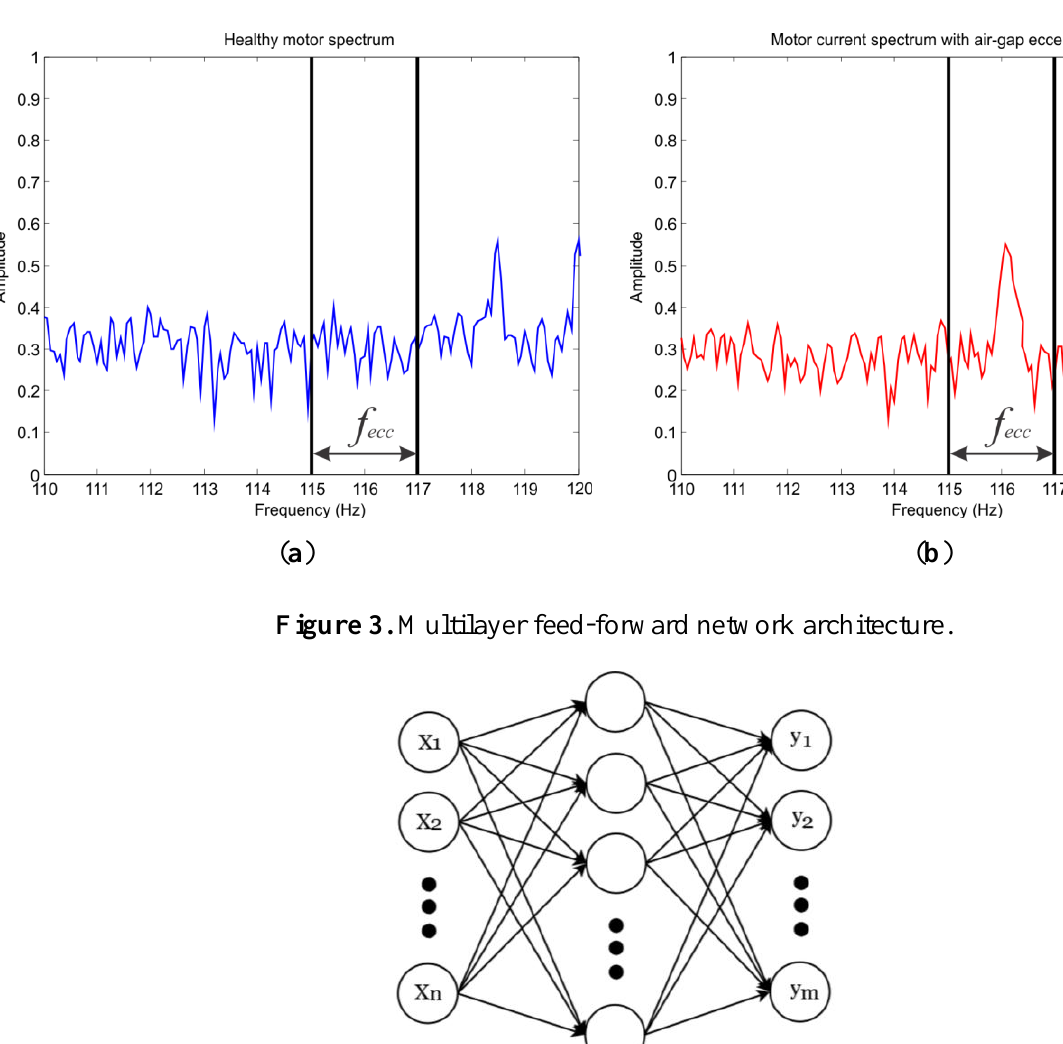
Figure 2. Air-gap eccentricities. ( a ) Healthy motor current spectrum; ( b ) Motor current spectrum with air-gap eccentricities.